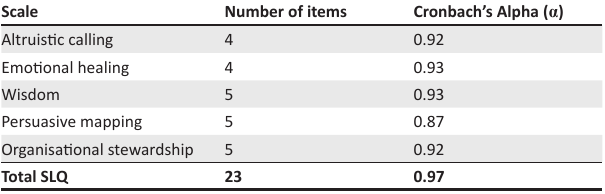
TABLE 2: Servant Leadership Questionnaire reliability coefficients.